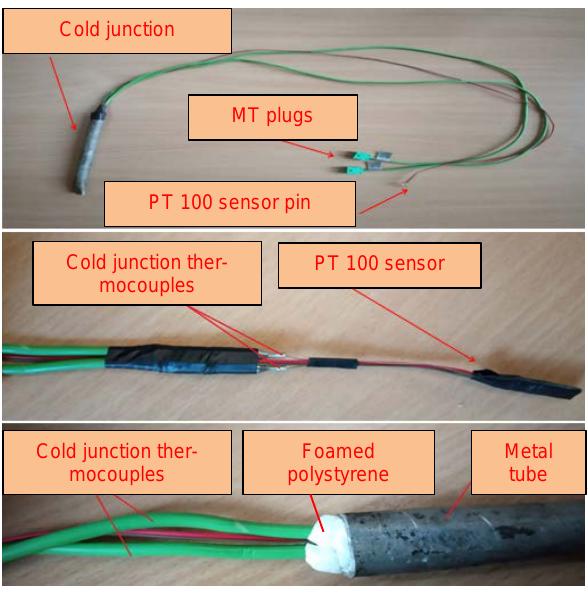
Fig. 5. Construction of actual temperature measurement